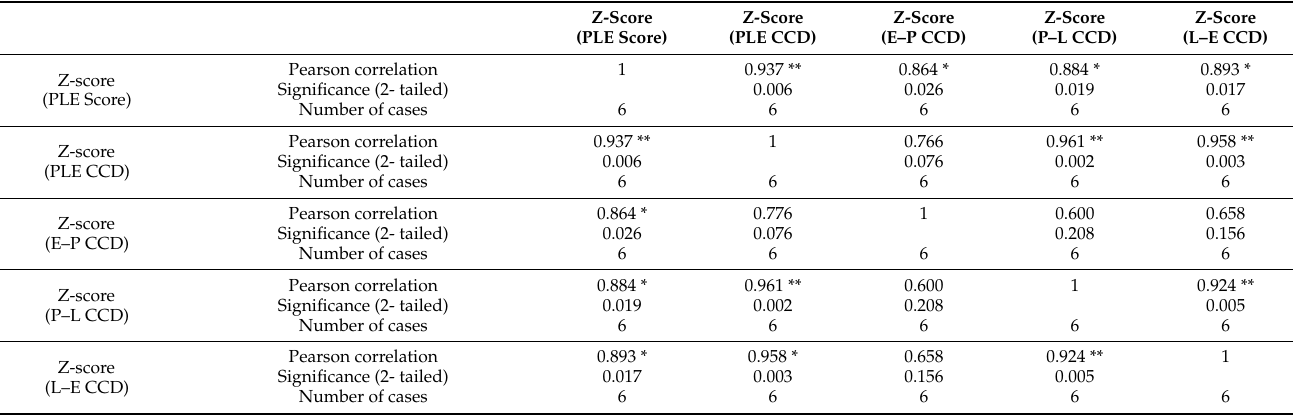
Table A2. Pearson correlation analysis Z-score results between PLE score, PLE CCD and pairwise mutual CCDs.